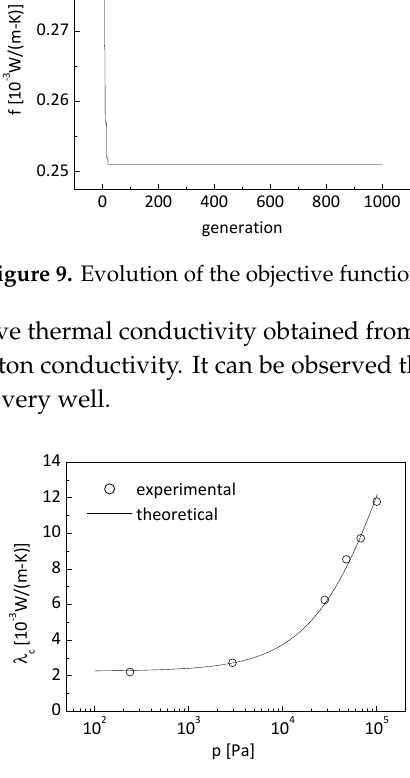
Figure 10. Effective thermal conductivity obtained from the theoretical model based upon the identified skeleton conductivity.